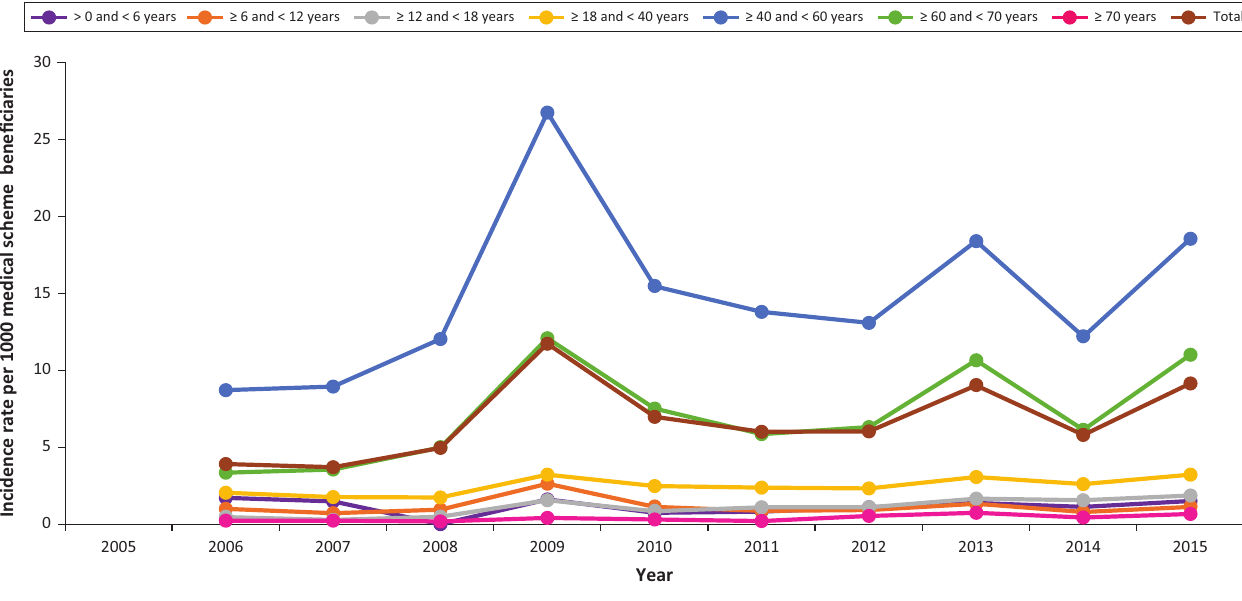
FIGURE 4: Incidence rate of human immunodeficiency virus or acquired immunodeficiency syndrome per 1000 medical scheme beneficiaries as per age groups from 2005 to